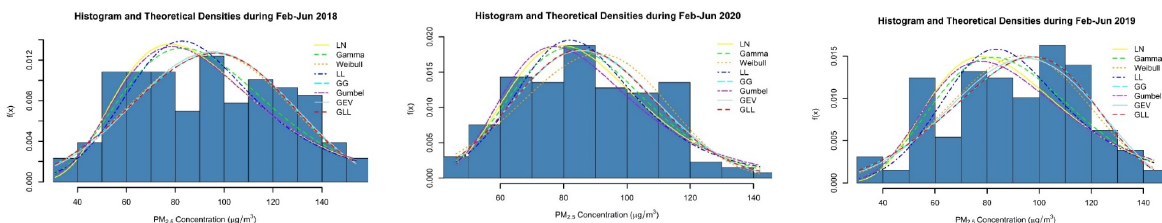
Fig. 4. Empirical PDFs of LN, gamma Weibull, LL, Gumbel, GG, GEV, and GLL plot distribution superimposed on relative frequency histograms of PM 2.5 concentrations in the period of without and during